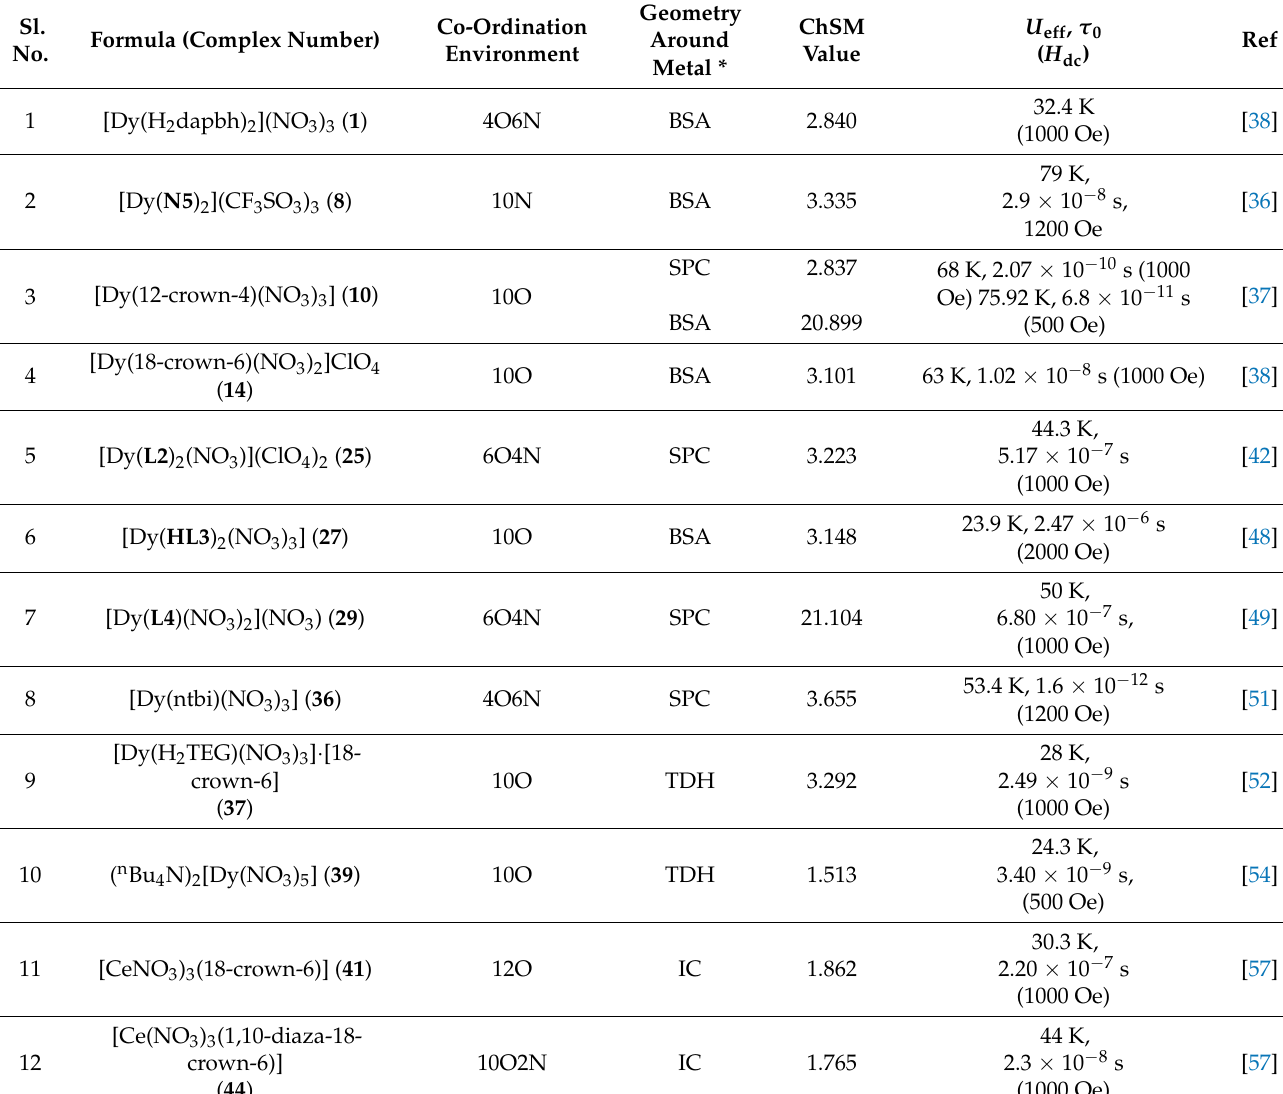
systems high U eff is possible when the geometry is bicapped square antiprism with high distortion. But when the geometry is sphenocorona the distortion should be low for getting high U eff . Table 2. A summary of the magnetic properties of all ten-coordinate Dy(III) and two dodeca-coordinated Ce(III)complexes. Geometry Co-Ordination Sl. Around Formula (Complex Number) Environment No.